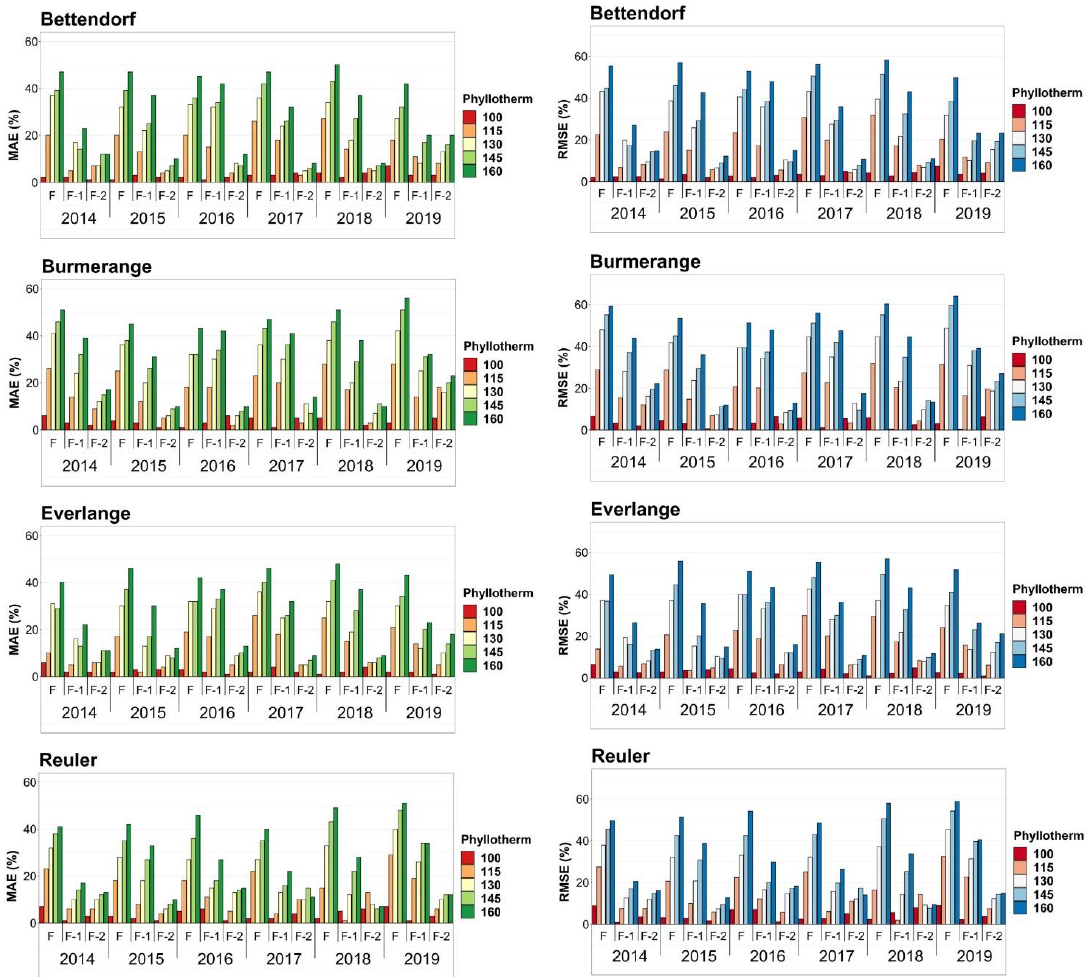
Figure 6. Mean absolute errors (MAE; left) and root mean square errors (RMSE; right) according to the phyllotherms tested for predicting the emergence of the upper leaves F, F-1 and F-2 in winter barley at the different study sites in the Grand-Duchy of Luxembourg. Phyllotherms are expressed in °Cd. F is the flag leaf.